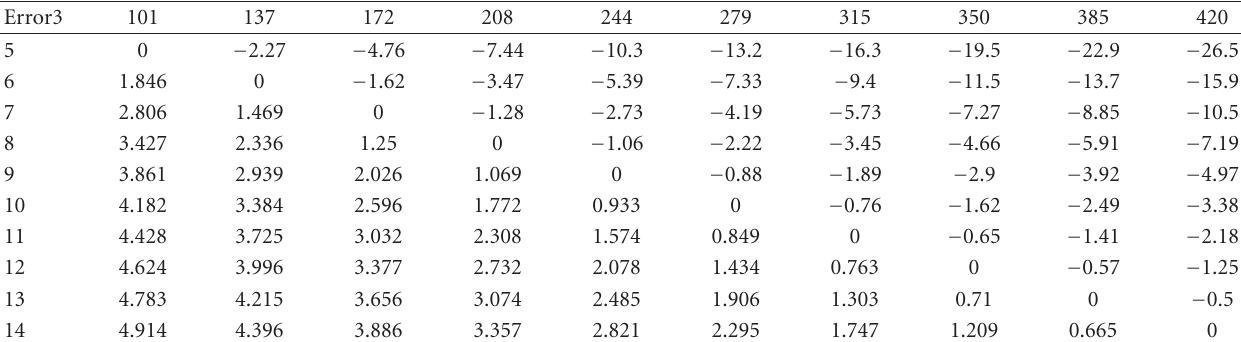
Table 4: MPG 1 versus Hb mix showing estimated error of measured HbA 1c for detection of patient’s MPG in 3-month intervals.